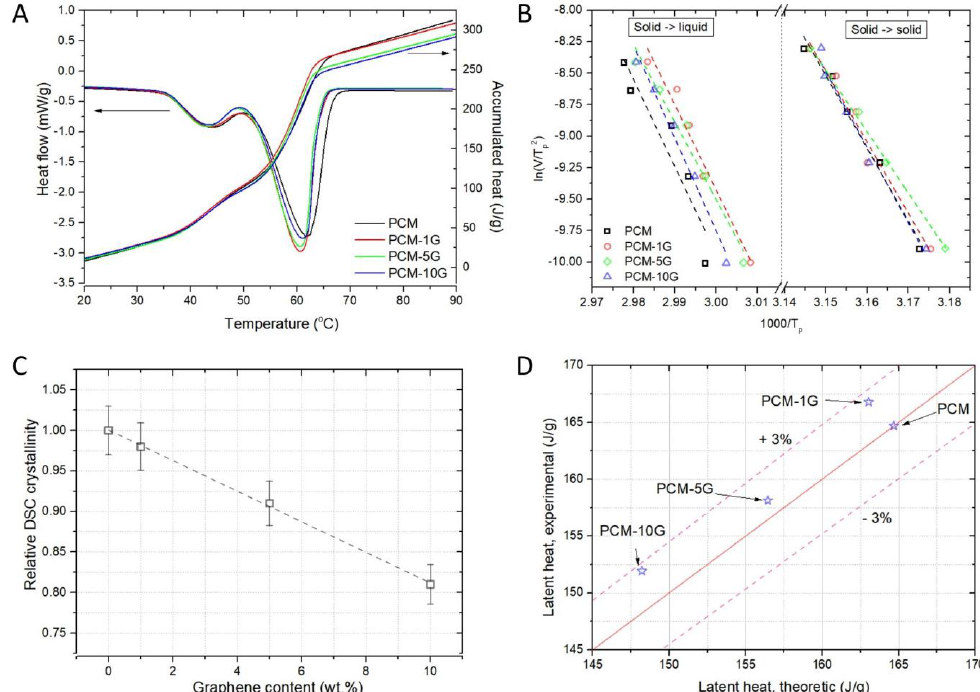
Figure 5. DSC analysis of paraffin- (PCM) and graphene-based composites: ( A ) heat flow curves vs. temperature and the corresponding accumulated heat recorded under 80 mL min −1 nitrogen flow, at a heating rate of 10 °C min −1 ; ( B ) graphic representation 𝑙𝑛(𝑇 𝑝2 𝑣⁄ ) vs. 1 𝑇 𝑝 ⁄ , where the slope of the line resulting from linear fitting is proportional to the activation energy according to the Kissinger equation; ( C ) relative DSC crystallinity dependence on the graphene content; ( D ) latent heat evaluated by integrating the corresponding peak on the DSC curves in ( A ) compared to the theoretically estimated values. Table 1. Melting and crystallisation temperatures and activation energies for the solid–solid and solid–liquid phase transitions estimated using the Kissinger model. Solid–Solid